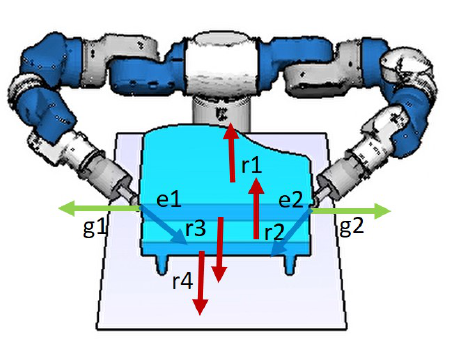
Figure 5. Selection of grasps with respect to the surface normals of the object and the rotational vector of the EEF (e1 and e2). The contact pairs on surfaces with normal vectors r1 and r2 are removed because collision occurs between the table and EEF if the EEF contacts the bottom of the piano. The contact pairs on surfaces with normal vectors r3 and r4 are removed because they are too far to be reached by the EEFs. The contact points on the surface with normal vectors g1 and g2